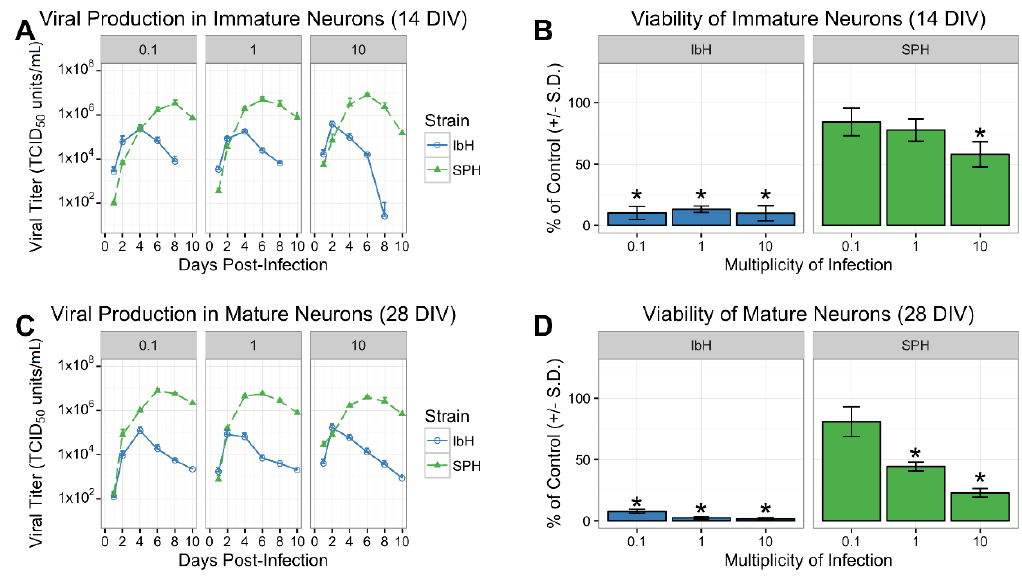
Figure 2. ZIKV isolate-specific growth and cytotoxicity in human neurons. ( A,B ) Viral replication and viability of hNP-derived nascent neurons (14 DIV) and ( C,D ) mature neurons (28 DIV) six days post-infection. * demonstrates p < 0.05.